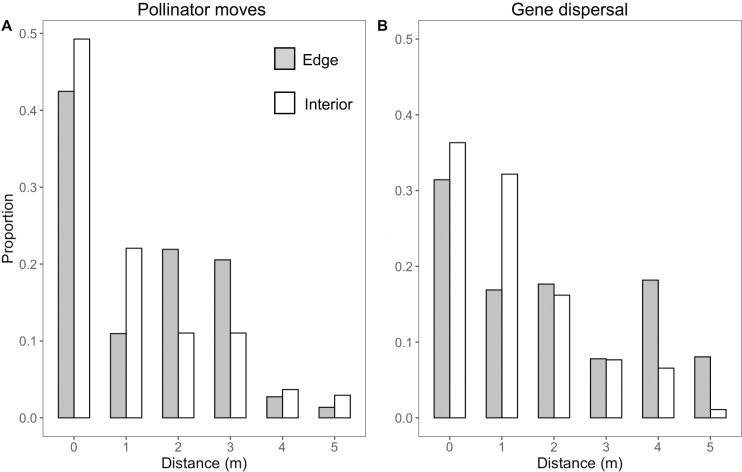
Pollinator movements and pollen-mediated gene dispersal for edge and interior plants. X-axis categories are abbreviated; true ranges are 0–0.999, 1–1.999, etc. N for pollinator moves = 73 for edge plants and 136 for interior. N for gene dispersal = 385 for the edge and 457 for the interior.